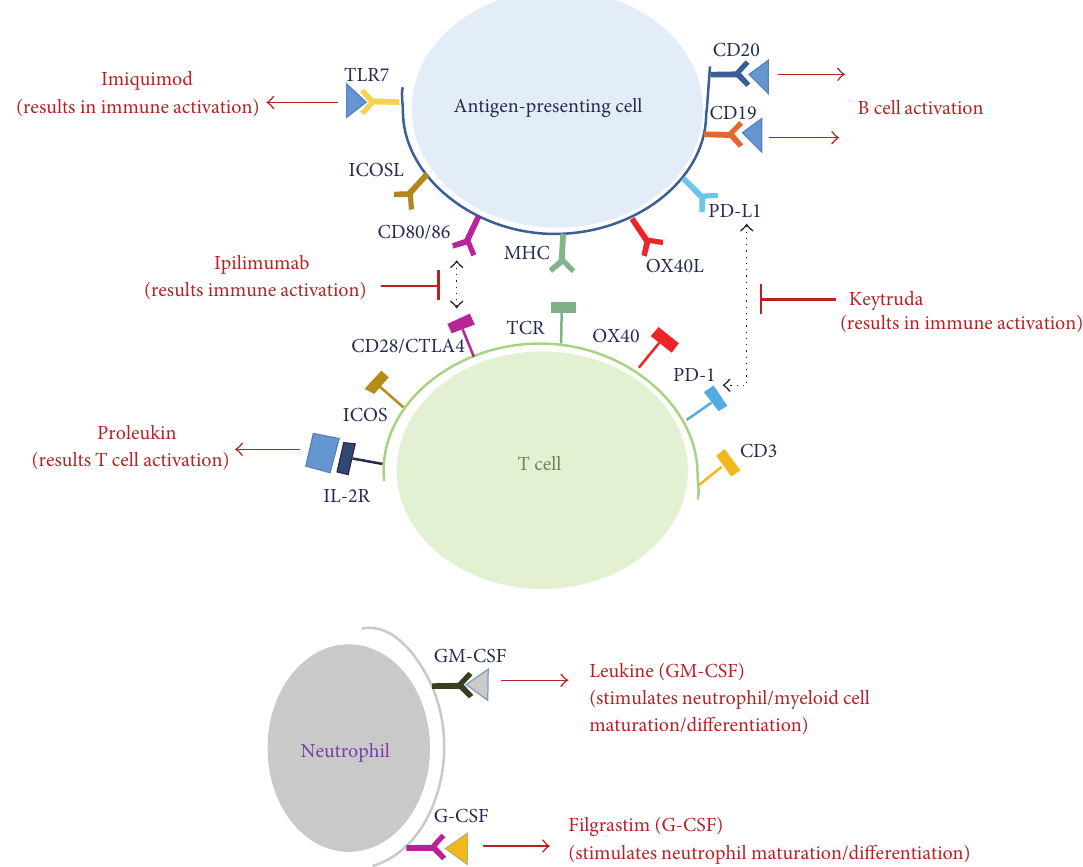
Figure3:Immunotherapiesincancer.SeveralFDAapprovedimmunotherapieshavebeenapprovedinthemarkettopreventorcontrolcancer progression [1]. On APCs (such as B cells), monoclonal antibodies targeting CD20 (Rituximab) results in downregulation of B cell activity [62]. Other antigen-presenting cells (macrophages and dendritic cells) are also activated by Imiquimod, a small molecule agonist for TLR7 [1]. For activation of T cells Keytruda (monoclonal antibody targeting PD-L1- PD-1 interaction) and Ipilimumab (antibody against